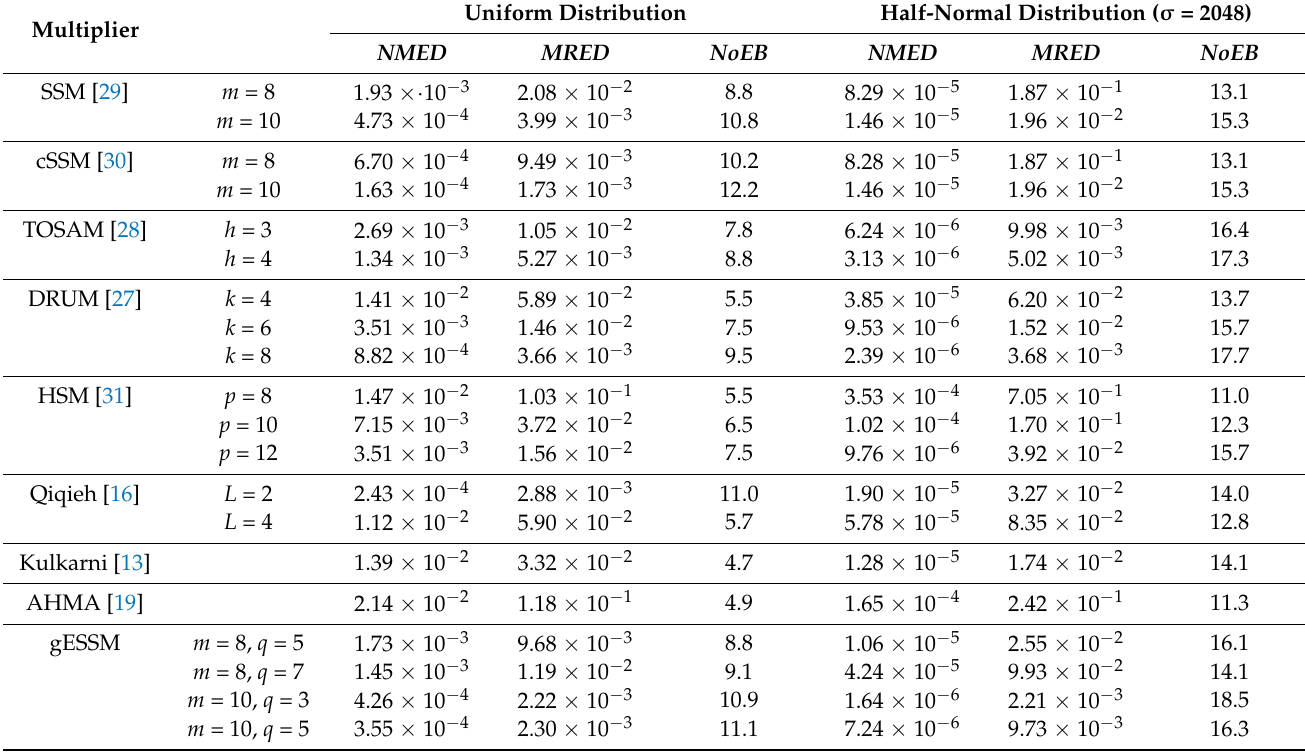
Table 4. Error metrics of the investigated multipliers for n = 16